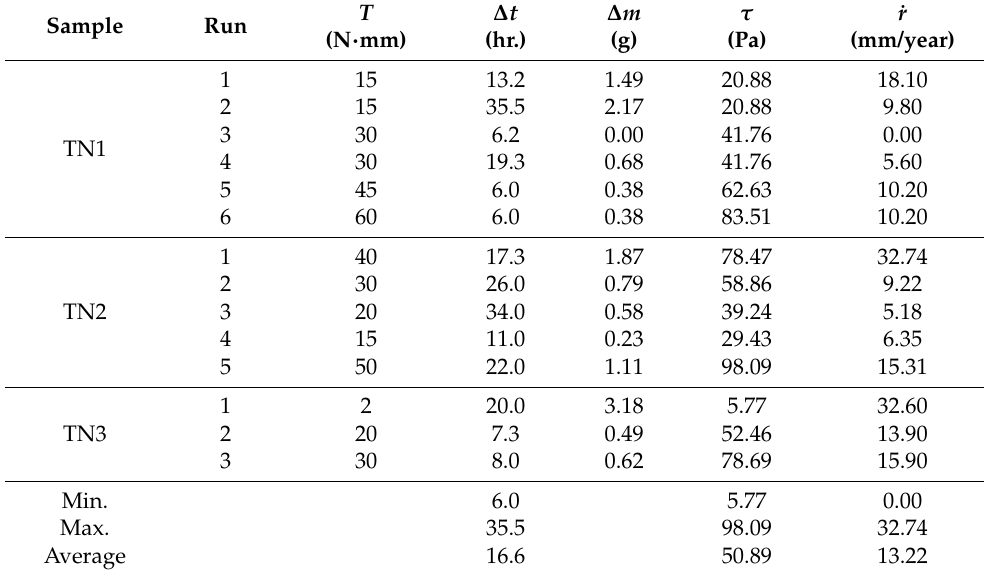
Table 3. Rate erosion ˙ r obtained from RETA tests for samples extracted from North Tower (samples: TN1, TN2 and